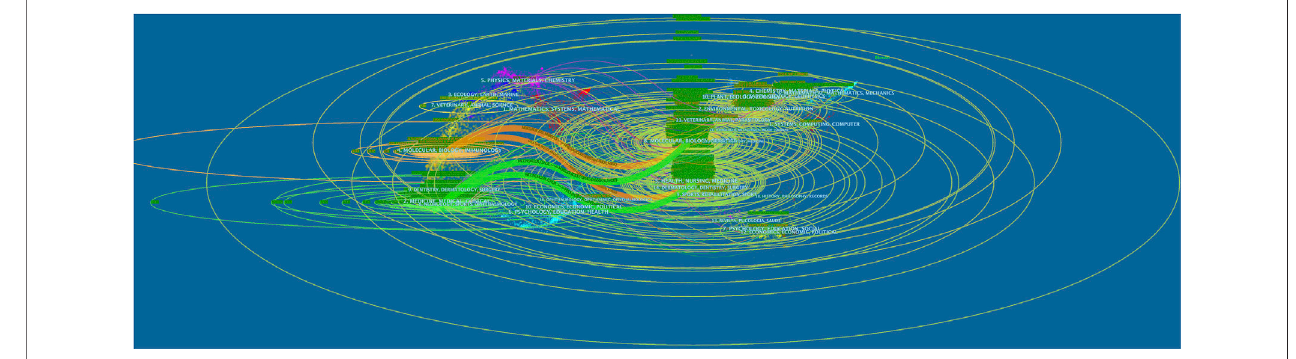
FIGURE 5 | The dual-map overlay of journals associated with the treatment of liver fi brosis (Left: the citing journals; Right: the cited journals).jpg.